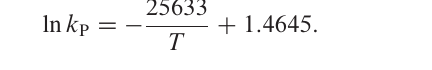
2.2 (cid:2) 10 (cid:3) 5 m = s for 1450 ı C, 1548 ı C and 1642 ı C,